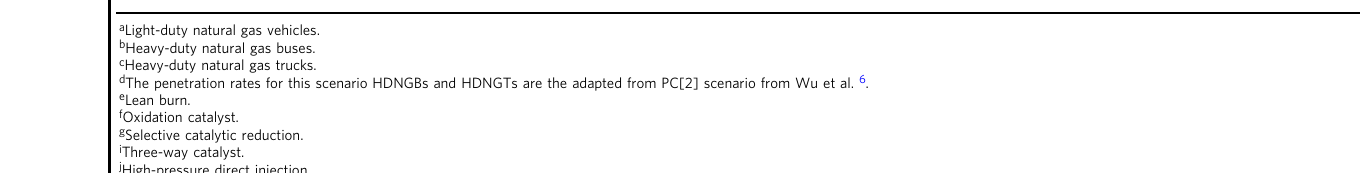
d The penetration rates for this scenario HDNGBs and HDNGTs are the adapted from PC[2] scenario from Wu et al. 6 . e Lean